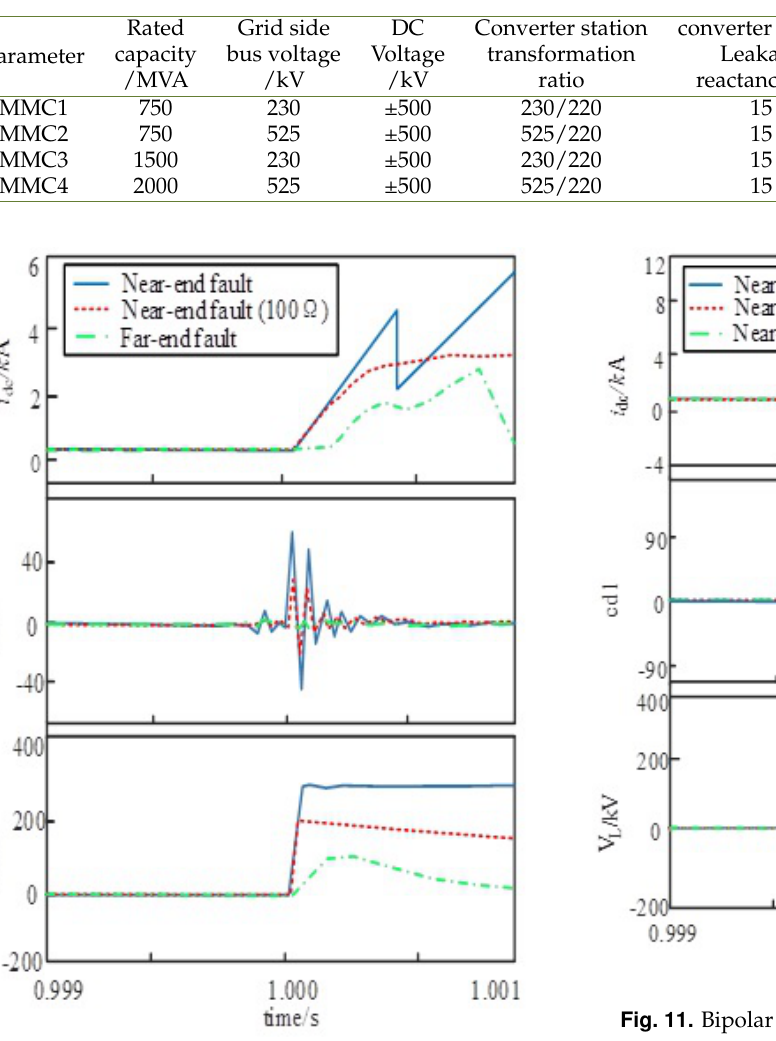
Fig. 10. Simulation results of single-pole earth fault.